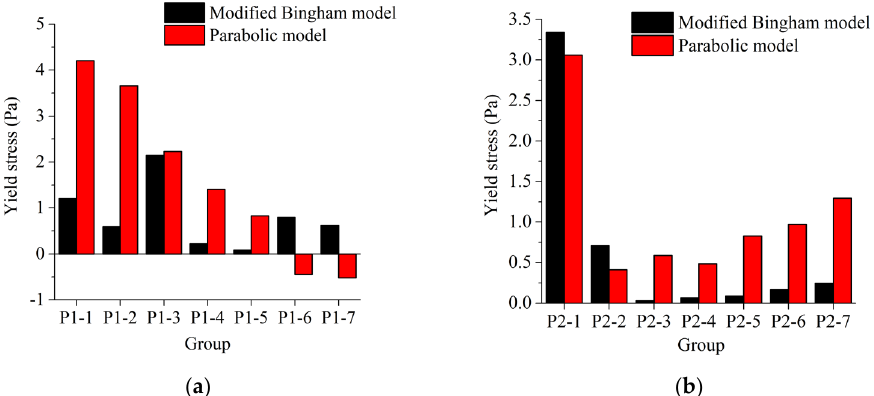
Figure 6. Comparison of yield stresses calculated based on two rheological models. ( a ) P1; ( b ) P2.